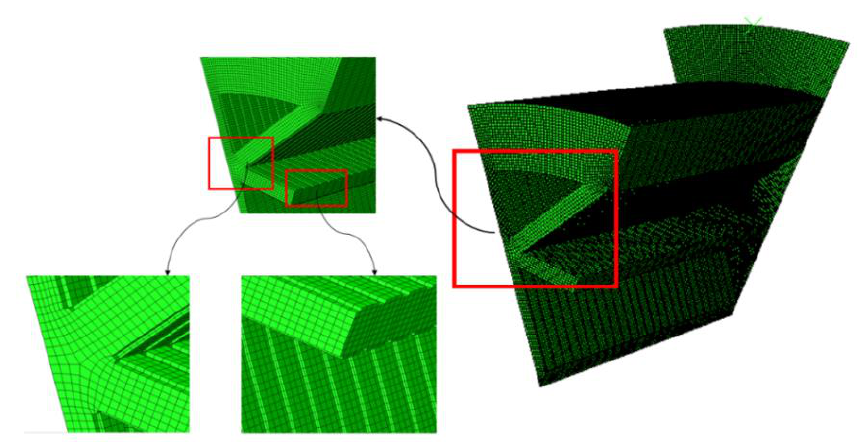
Figure 9. PLA 3D-printed model mesh.